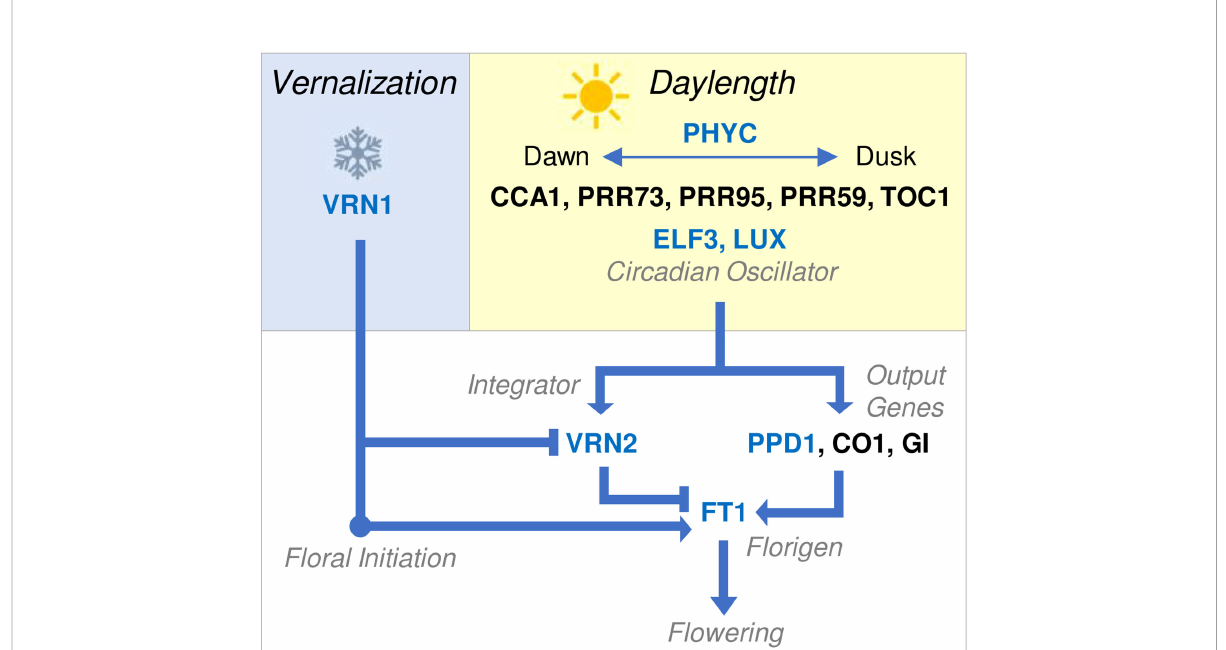
FIGURE 2 Overview of molecular genetic network controlling the seasonal fl owering behaviour of temperate cereals. Vernalization (blue box) activates VRN1 . This is suf fi cient to trigger the transition to reproductive development or fl oral initiation, as indicated by the double ridge stage of shoot apex development. Additionally, VRN1 represses VRN2 and activates FT1 , allowing the daylength fl owering response to occur after vernalization. Daylength perception (yellow box) is mediated by the circadian oscillator, which generates internal biological rhythms that allow perception of external photoperiod. The circadian oscillator regulates output genes (white box) that activate FT1 , the key trigger for daylength-induced fl owering also known as fl origen. VRN2 is also daylength responsive and blocks long-day induction of FT1 , until VRN2 is itself repressed by VRN1 . FT1 accelerates reproductive development and stem elongation, leading to fl owering. Arrows indicate activation of a target gene, lines ending in bars indicate repression. Blue text indicates that a gene has been linked to (or associated with) natural variation for seasonal fl owering behaviour. Gene names are shown without italics for clarity and blue text indicates genes known to mediate natural variation in phenology of other